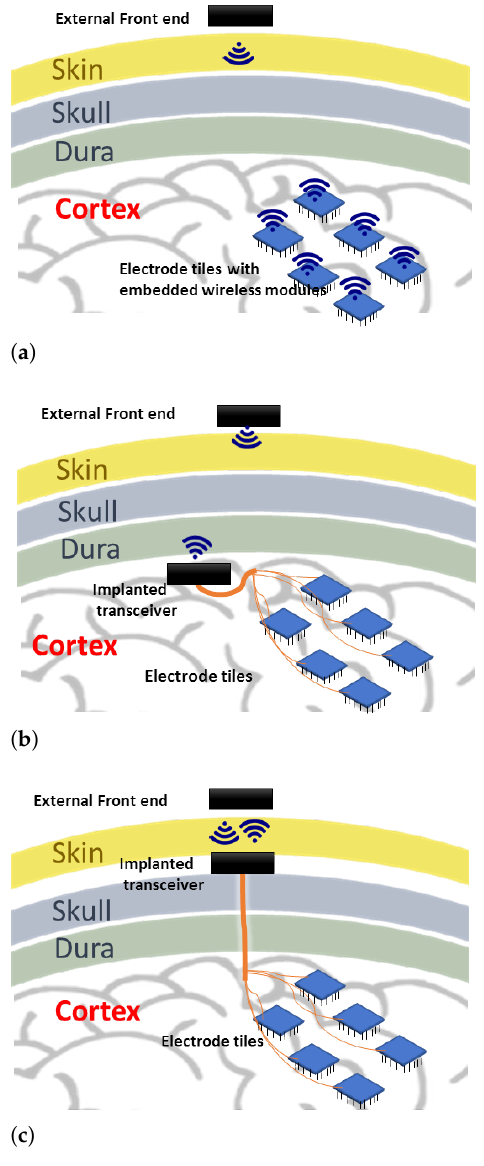
Figure 1. Various system layouts for the wireless enabled visual prosthesis. ( a ) place the implanted transceiver embedded into each electrode array; ( b ) use a central transceiver placed beneath the skull; ( c ) place the implanted transceiver beneath the